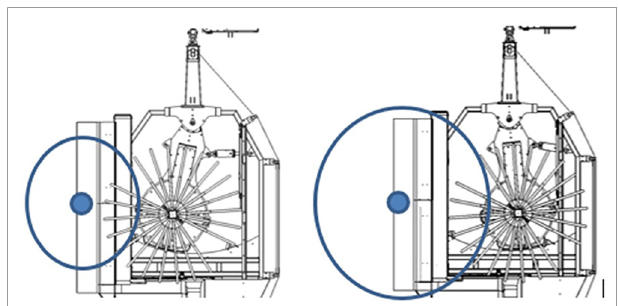
FIGURE 8 | Top view of the Side-Row Continuous Canopy Shaking Harvester showing lateral position of the vibratory mast.